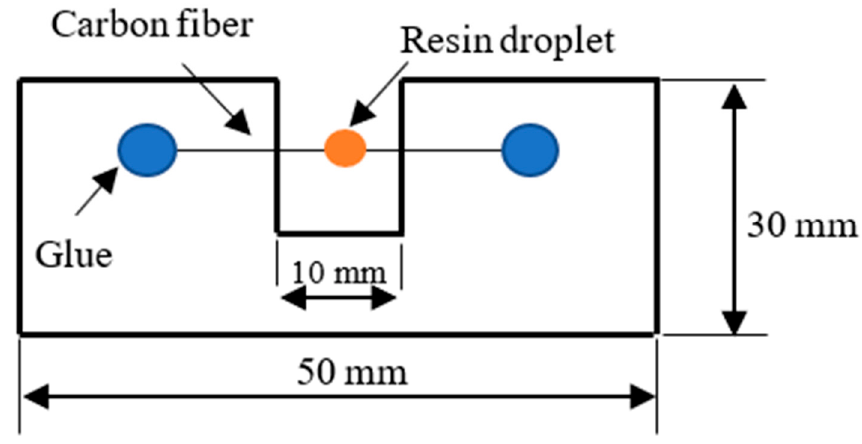
Figure 1. The geometry of the single carbon fiber containing one resin drop adhered to the paper frame.